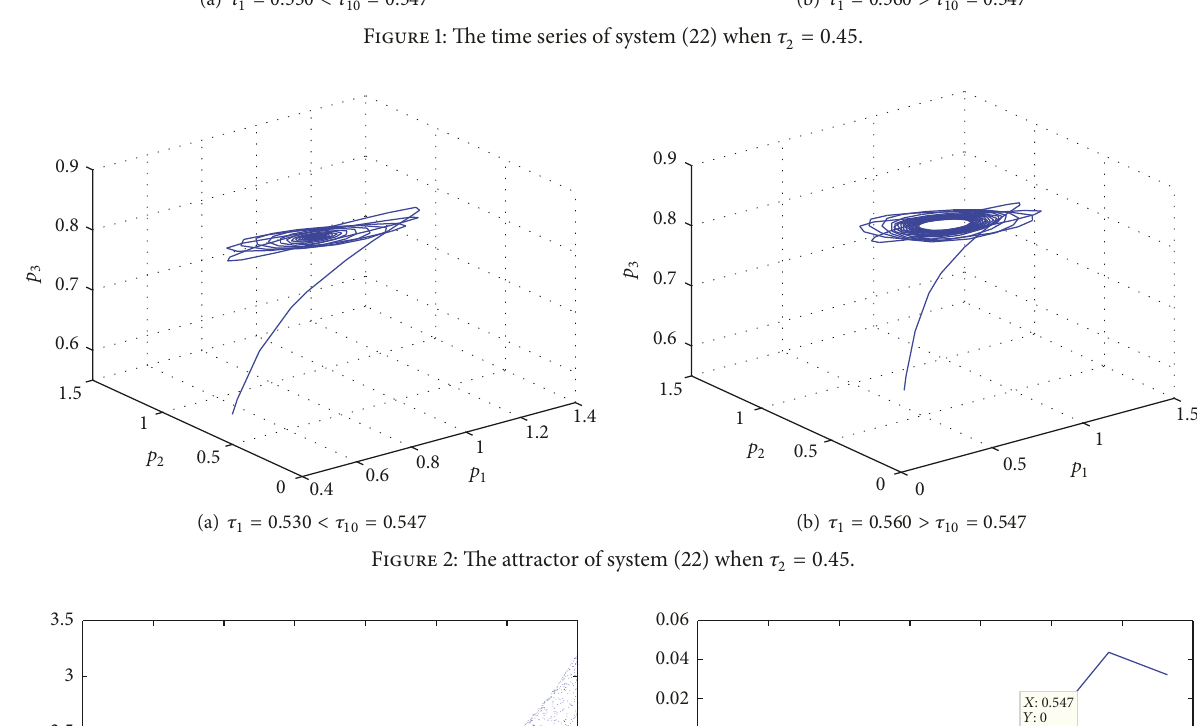
Figure 1: The time series of system (22) when 𝜏 2 = 0.45 .